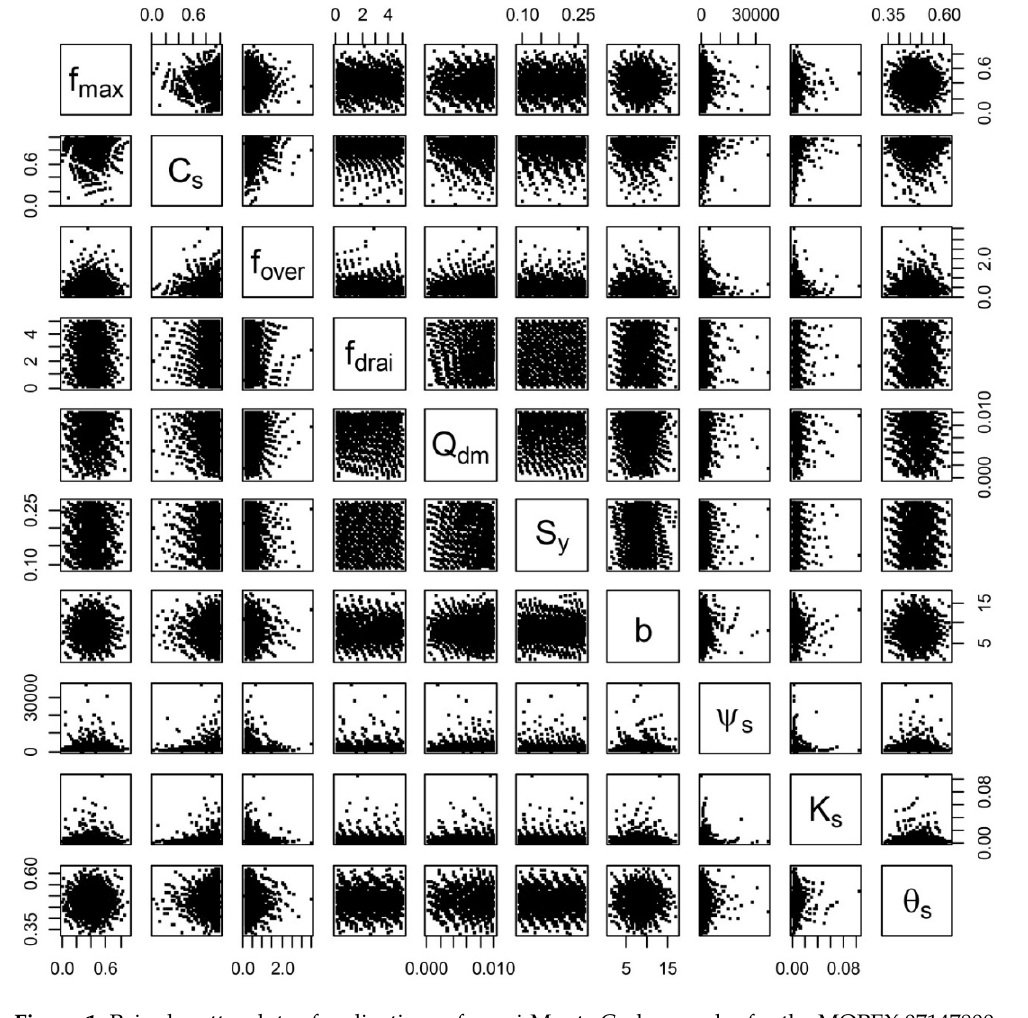
Figure 1. Paired scatterplots of realizations of quasi-Monte Carlo samples for the MOPEX 07147800.